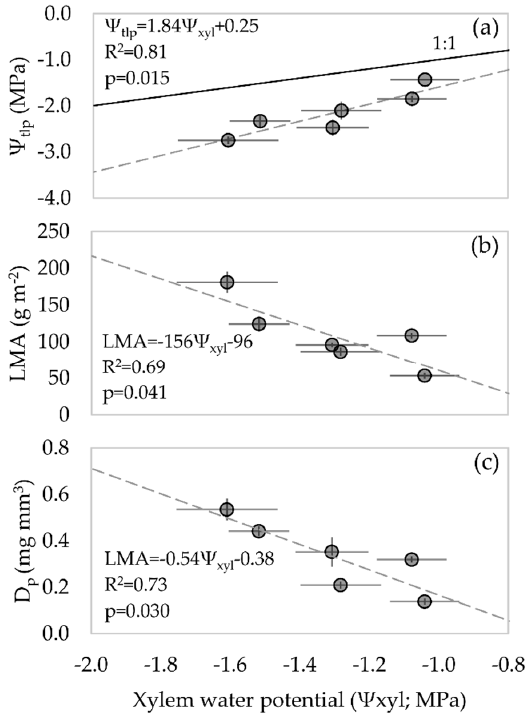
Figure 3. Relationship of Ψ xyl with Ψ tlp ( a ), LMA ( b ), and D p ( c ). Each point represents the mean per species ± standard error (n = 6). The solid line in ( a ) represents a 1:1 relationship between Ψ xyl and Ψ tlp .